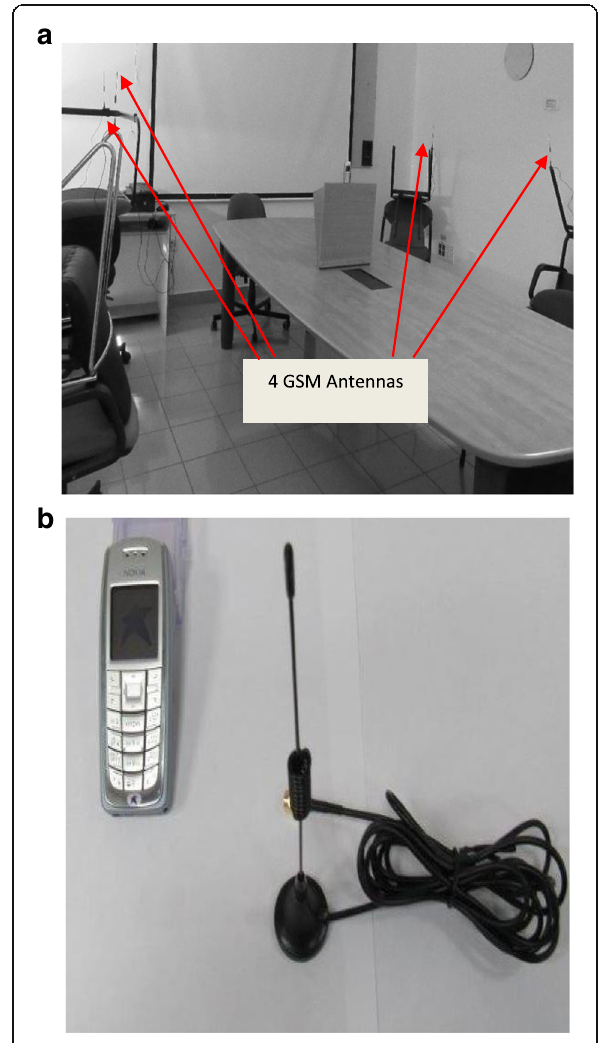
Fig. 7 a Indoor experimental set-up; ( b ) Nokia 6120 cellphone and GSM dual-band (900 and 1800 MHz) magnetic